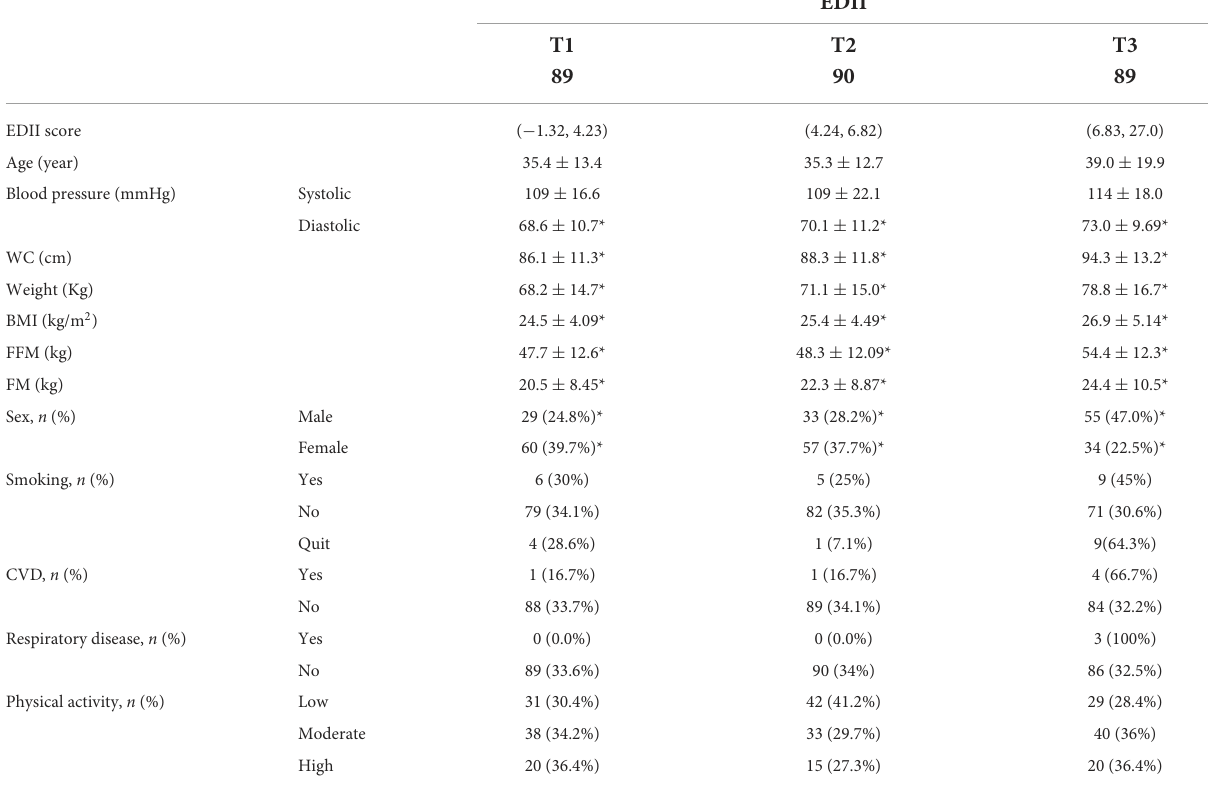
TABLE 1 General characteristic of participant according to the tertile of